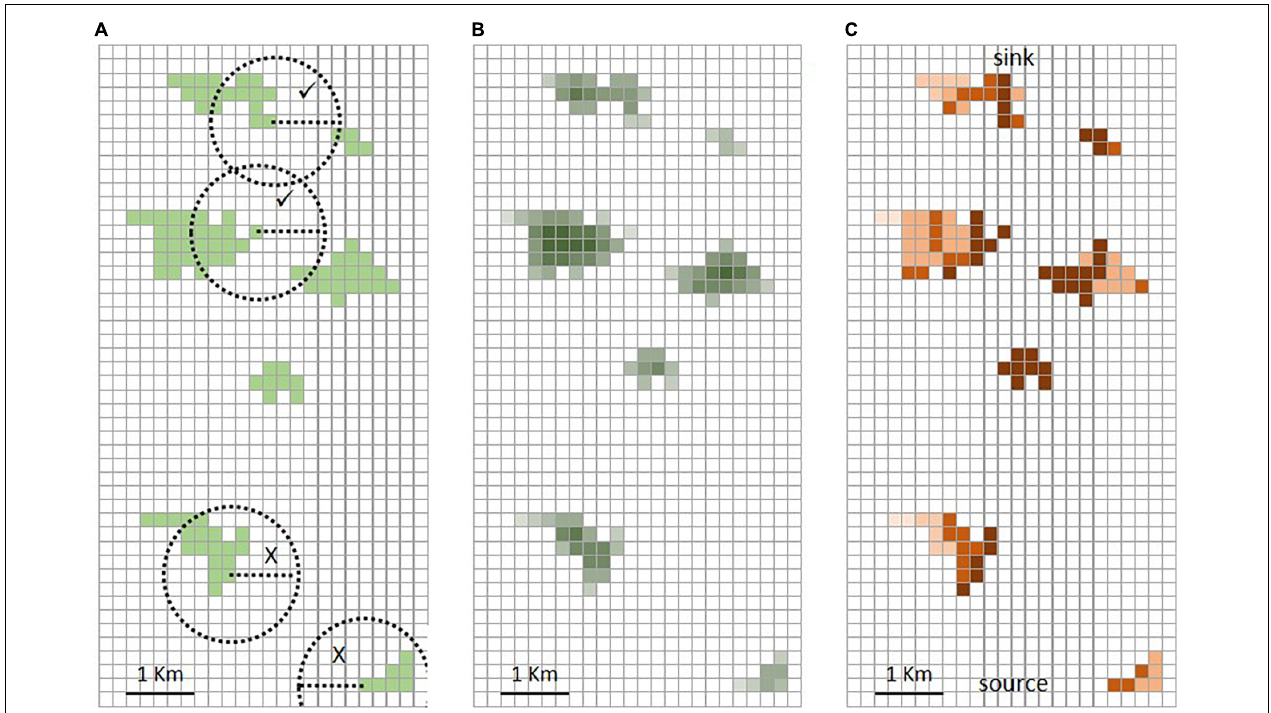
FIGURE 1 | Graphic representation of the three tools tested. (A) The rule of thumb (RT) metric is based on Euclidean distance between patches; we used a moving window to determine if each patch of focal habitat had a nearest neighbor within a 1 km radius. (B) The National Biodiversity Climate Change Vulnerability Assessment Tool (NBCCVAT) tool calculates an index of habitat fragmentation, by scoring each cell of focal habitat according to the number of habitat or non-habitat cells surrounding it. (C) Condatis represents movement across the landscape as current flowing through an electrical circuit; it scores each habitat cell according to its contribution to the overall